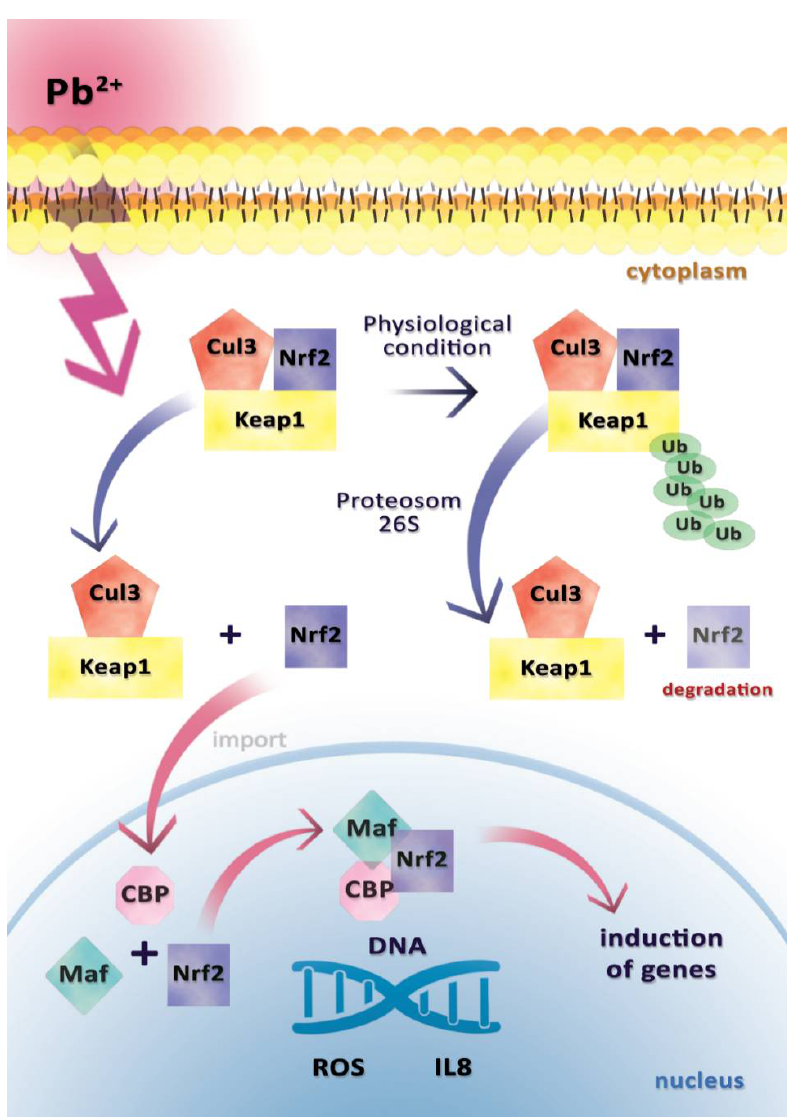
Figure 2. Mechanism of activation and inactivation Nrf 2 by Pb 2+ . In physiological conditions, Nrf2 binds to its inhibitor, Kelch-like ECH-associated protein 1 (Keap1). This is followed by the dimerization and then sequestration of Nrf2 in the cytoplasm. The Keap1–Nrf2 complex connects ubiquitin (via the Cul 3-dependent ligase) and is recognized by the 26S proteosome, where the Nrf2 transcription factor is degraded. After exposure to Pb 2+ , Nrf2 is released from the Keap1–Nrf2 complex, and translocated to the nucleus, where a small Maf protein attaches forming a heterodimer and CREB-binding protein (CBP). The incorporation of the newly formed complex into DNA initiates the transcription of antioxidant response genes and IL-8 gene results in enhanced reactive oxygen species (ROS) and IL-8 synthesis.